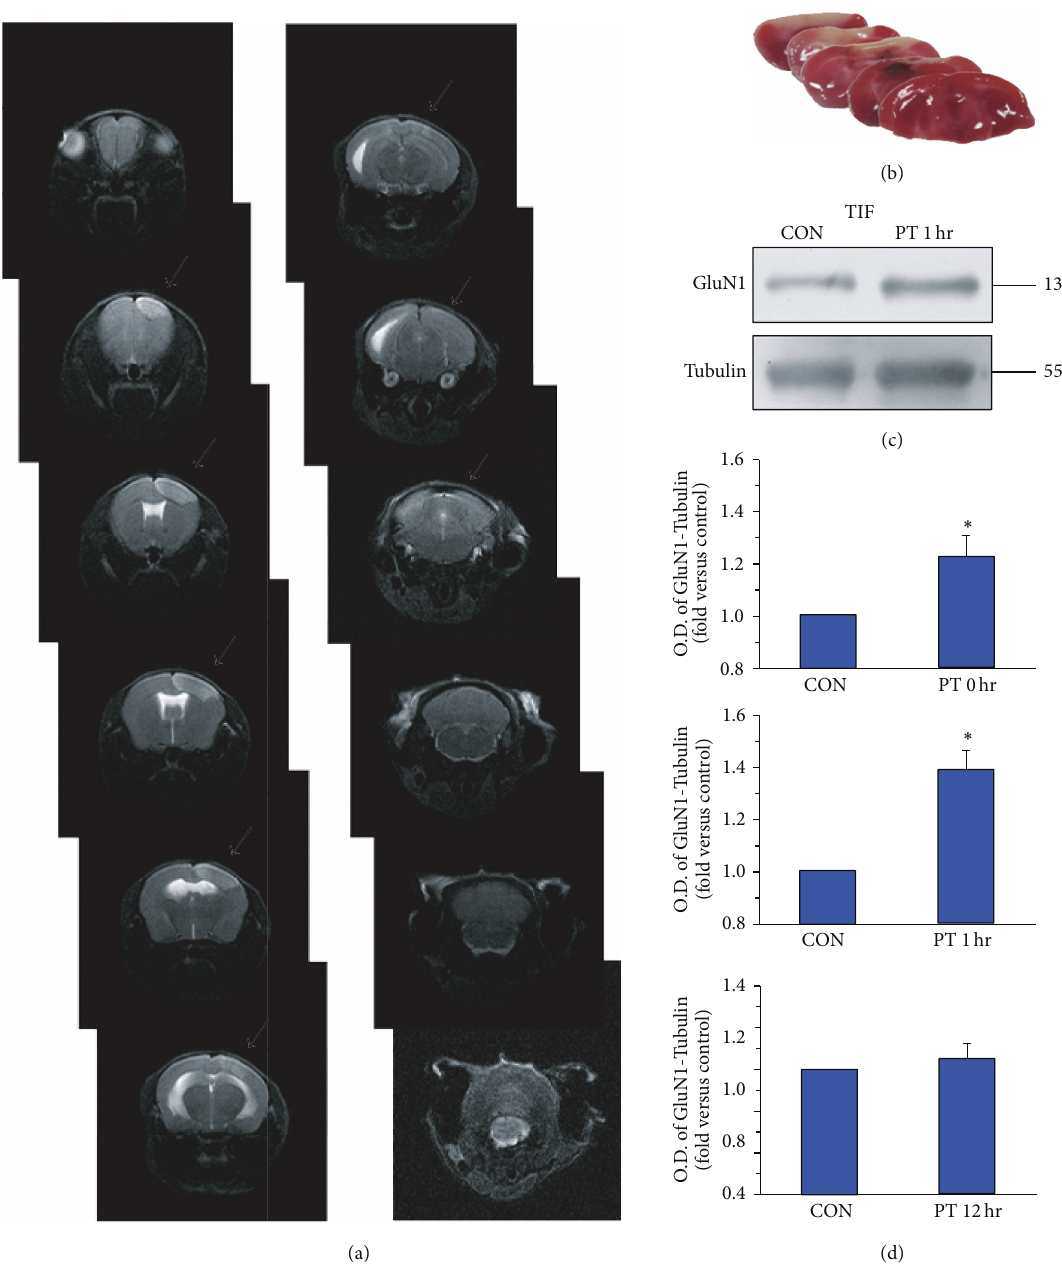
Figure 2: (a) Sequential brain T2-w MRI in an individual mouse with photothrombotic lesion. White arrows indicate infarct region. (b) A series of representative brains stained with TTC after photothrombotic lesion. Pale staining indicates infarct region. (c) Detected by Western blotting, a potentiation of NMDAR in TIF caused by the photothrombotic lesion 1hr after modeling was shown. (d) Statistical plots of data showing the effects of photothrombotic lesion (0hr after PT, 1.22 ± 0.08 , 𝑛 = 5 , ∗ 𝑃 < 0.05 ; 1 hr after PT, 1.39 ± 0.07 , 𝑛 = 6 , ∗ 𝑃 < 0.05 ; 12hr after PT, 1.05 ± 0.07 , 𝑛 = 5 , 𝑃 > 0.05